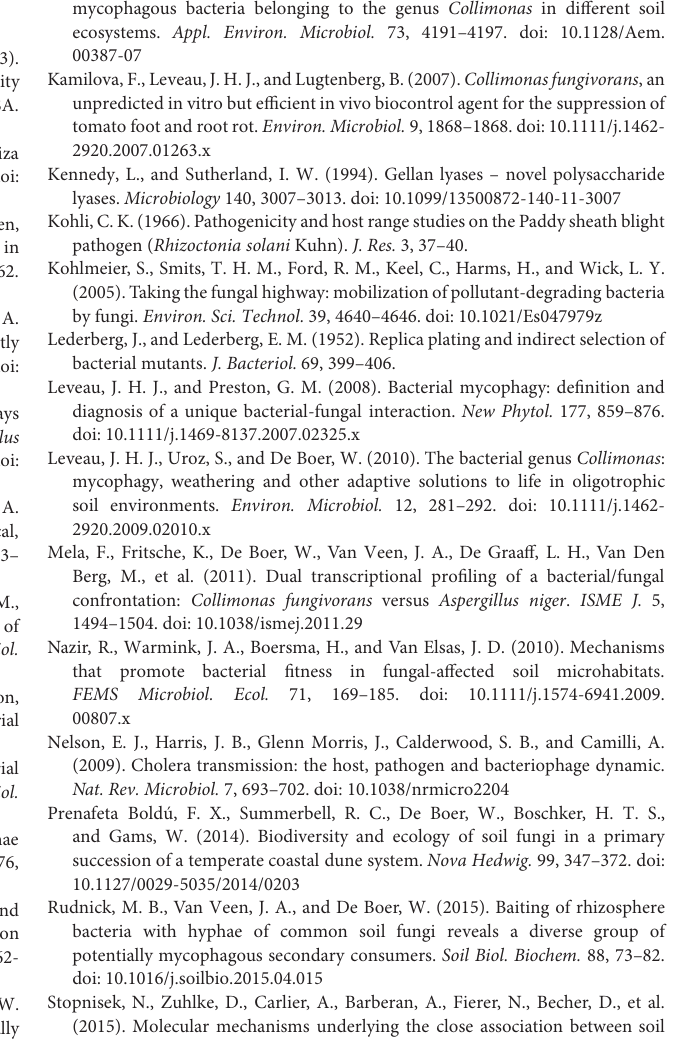
FIGURE S1 | Experimental setup of the confrontation assay. During colony expansion, the confrontation of the fungus (center) and bacterial colonies (blue) is forced. FIGURE S2 | Microscopic images of the mycophagy assay. Growth of bacterial strains Burkholderia sp. Kas203-3 and Luteibacter rhizovicinus on the fungi Mucor hiemalis, Trichoderma harzianum, and Rhizoctonia solani is shown. Controls showing bacteria or fungi inoculated on Phytagel medium alone are presented, as